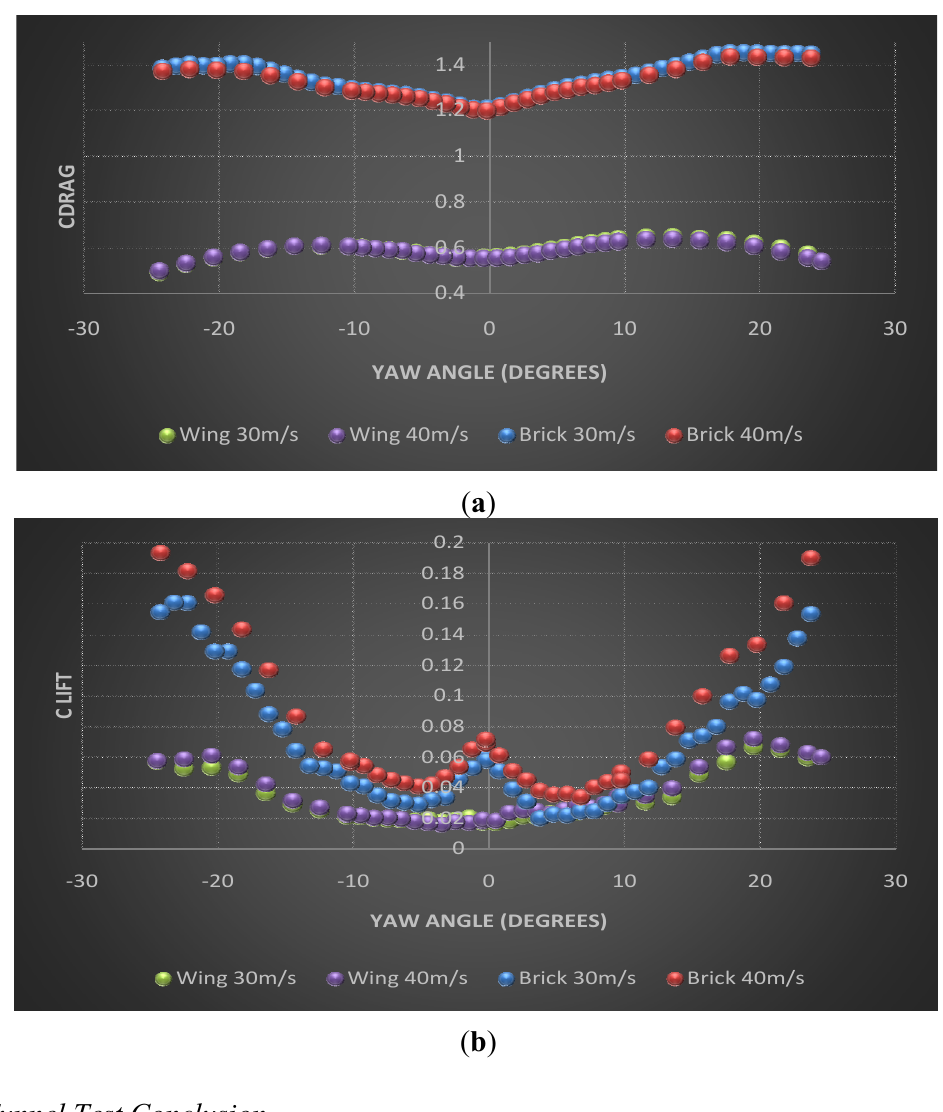
Figure 7. ( a ) Wing and Brick Yaw Angles versus CDrag for 30 m/s and 40 m/s; ( b ) Wing and Brick Yaw Angles versus CLift for 30 m/s and 40